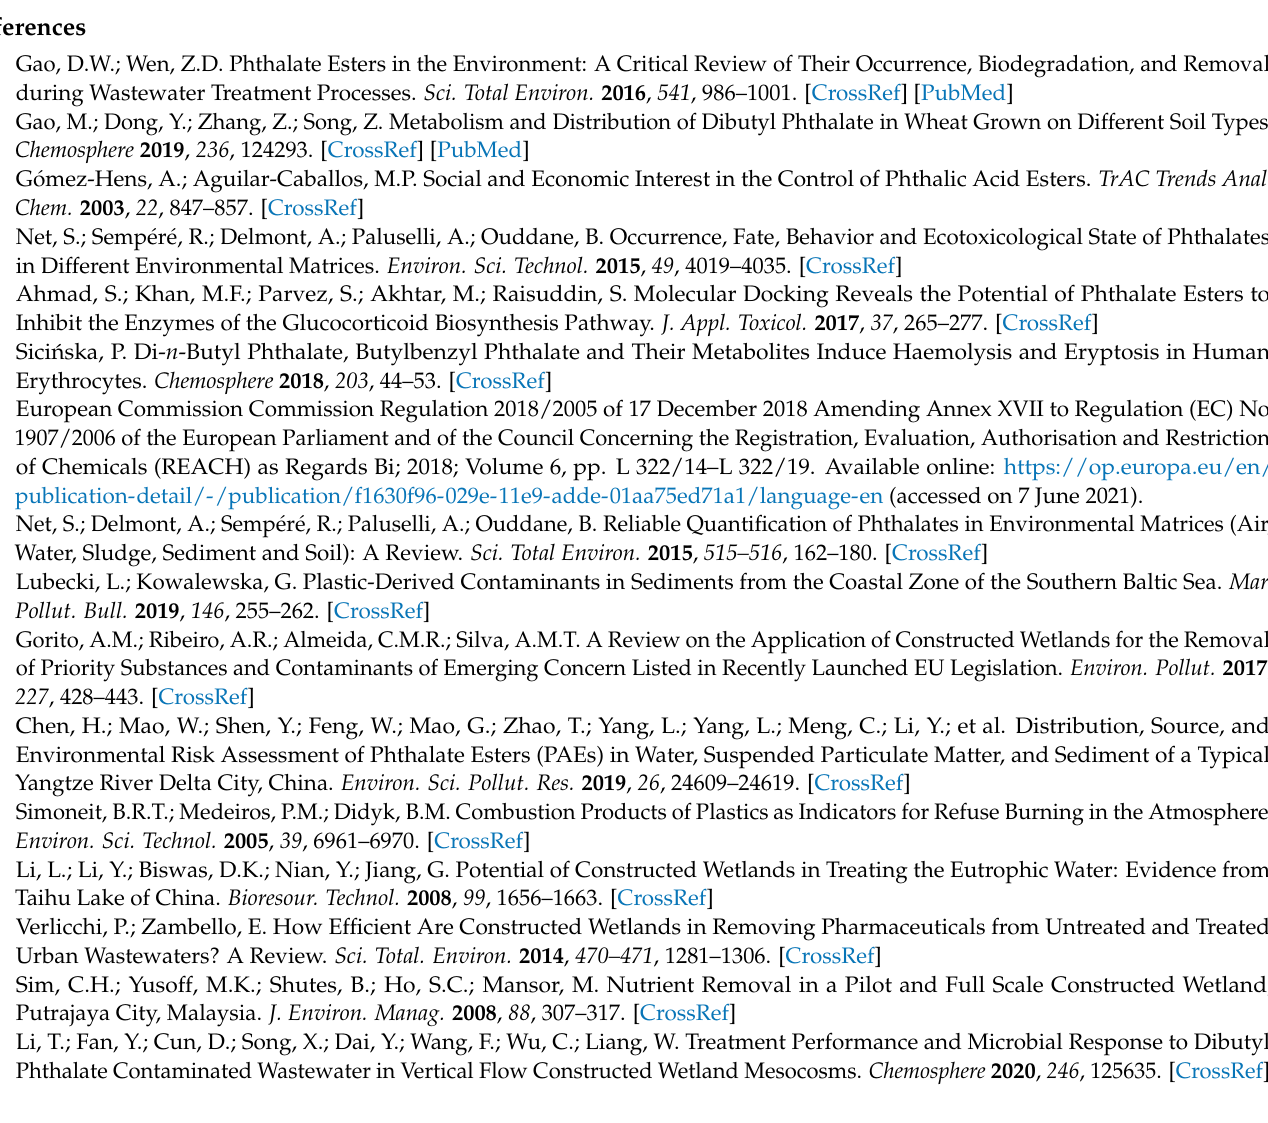
samples, Figure S6. Example chromatogram with marked SIM ions for determined target compounds in real European spindle ( Euonymus europaeus )